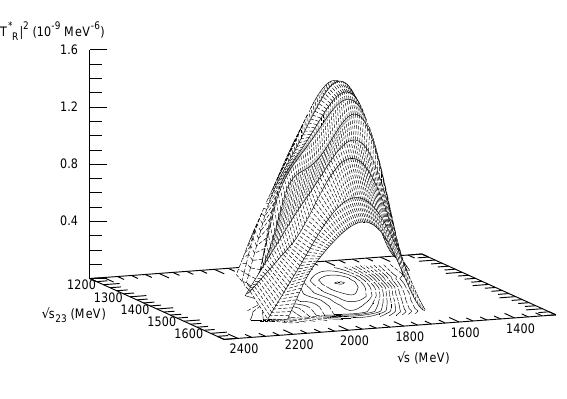
Fig. 1. The squared amplitude for the ππ N system in isospin 1 / 2 configuration as a function of √ s and √ s 23